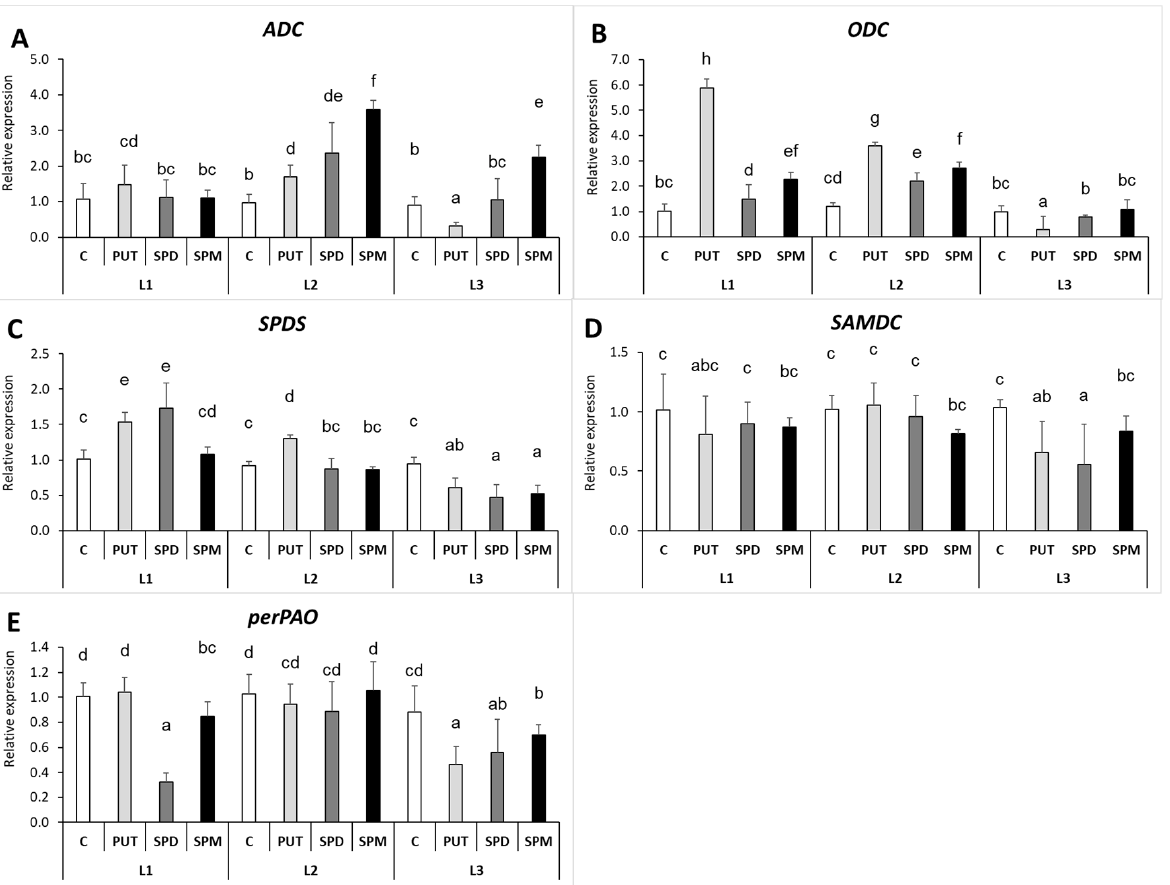
Figure 8. Effect of different light intensities on the gene expression patterns of arginine decarboxylase ( A ) ( ADC ), ornithine decarboxylase ( B ) ( ODC ), spermidine synthase ( C ) ( SPDS ), S-adenosylmethionine decarboxylase ( D ) ( SAMDC ), peroxisomal and polyamine oxidase ( E ) ( perPAO) in the roots of plants grown under 16 h/8 h day/night light period with different light intensity conditions: 500 (elevated light: L1), 250 (medium light: L2) and 50 (low light: L3) μ mol m 2 s − 1 LED light after 7 days of 0.3 mM exogenous putrescine (PUT), spermidine (SPD) or spermine (SPM) treatments or without any treatment (C). Data represent mean values ± SD. Different letters indicate significant differences at p ≤ 0.05 level, among all the values of the given compounds.